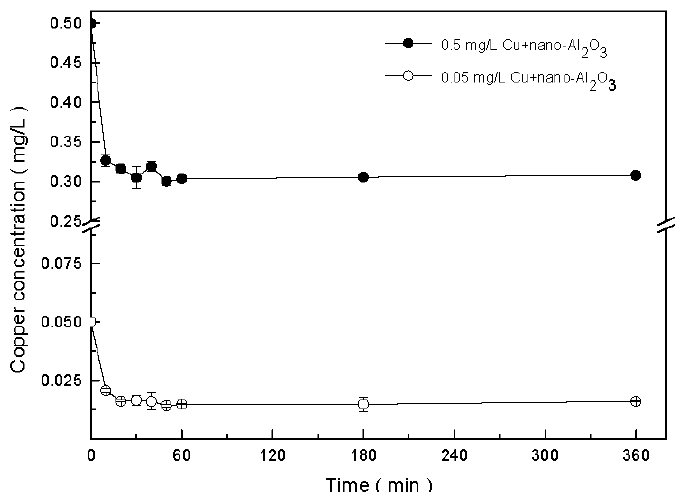
Figure 2. Adsorption of copper onto nano-Al 2 O 3 in the modified BG11 medium over 6 h. Data are mean ± SD ( n = 2).